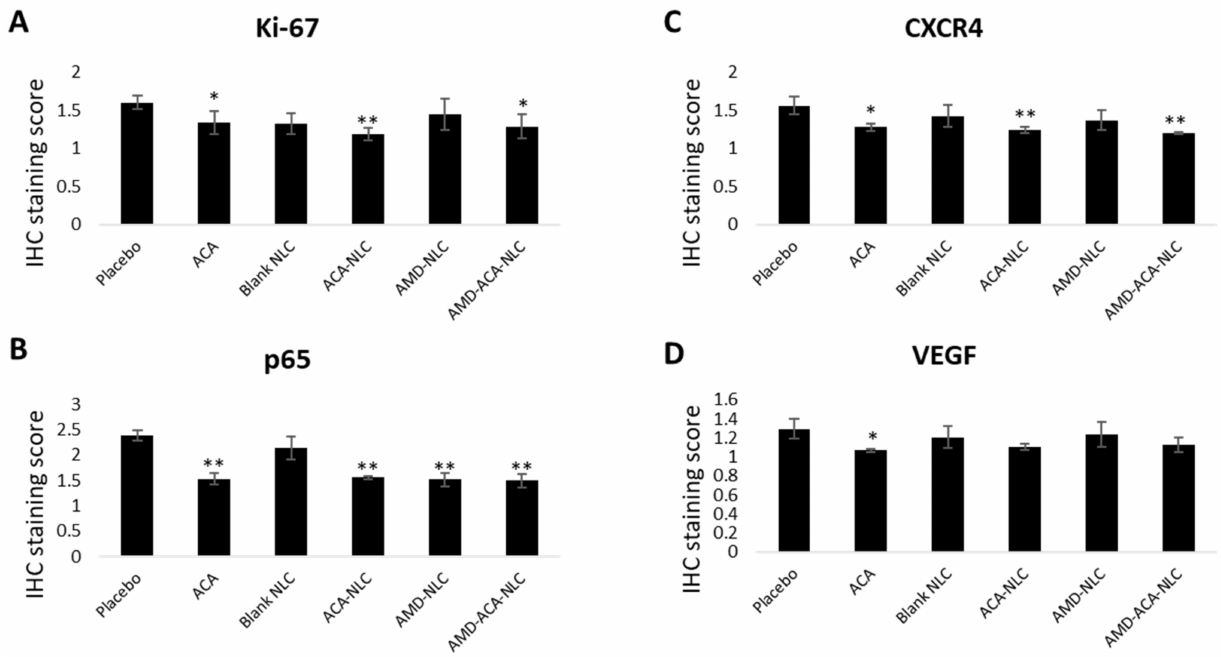
Figure 9. IHC staining score of tumor markers upon treatment with placebo, ACA, blank NLC, ACA-NLC, AMD-NLC, and AMD-ACA-NLC. ( A ) Ki-67, ( B ) CXCR4, ( C ) p65, and ( D ) VEGF protein staining score are shown. Significant difference between treatments and placebo group are indicated as * p < 0.05 and ** p < 0.01. All data are shown as mean ± S.D. of three independent